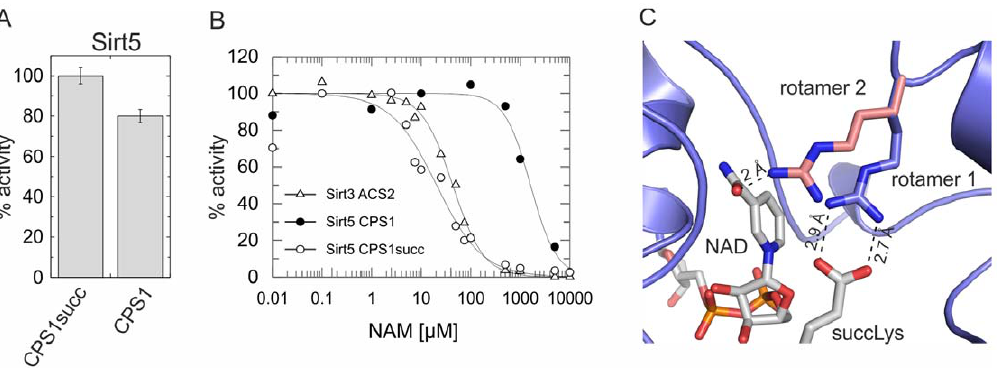
Figure 4. Nicotinamide effects on Sirt5 activity depend on the type of acyl group. ( A ) Comparison of Sirt5 activities against acetylated and succinylated CPS1-Lys527 peptide, determinded by mass spectrometry and normalized using the desuccinylation activity. Error bars represent standard errors of linear fits to time-series experiments. ( B ) Nicotinamide-dependent inhibition of Sirt5 activity against acetylated and succinylated CPS1-Lys527 peptide, determined using mass spectrometry and normalized against activity in absence of nicotinamide. The Sirt3/ACS2 and Sirt5/ CPS1 curves from Fig. 2A were added for comparison. ( C ) Cartoon representation of the Sirt5/succinylated substrate/NAD + complex structure. The ligands and Arg105 are shown as sticks colored according to atom type (ligands) or in blue (Arg105). A modeled alternative sidechain conformation for Arg105 (rotamer 2) is shown in red. CPS1succ, succinylated CPS1-Lys527 peptide; NAM, nicotinamide.